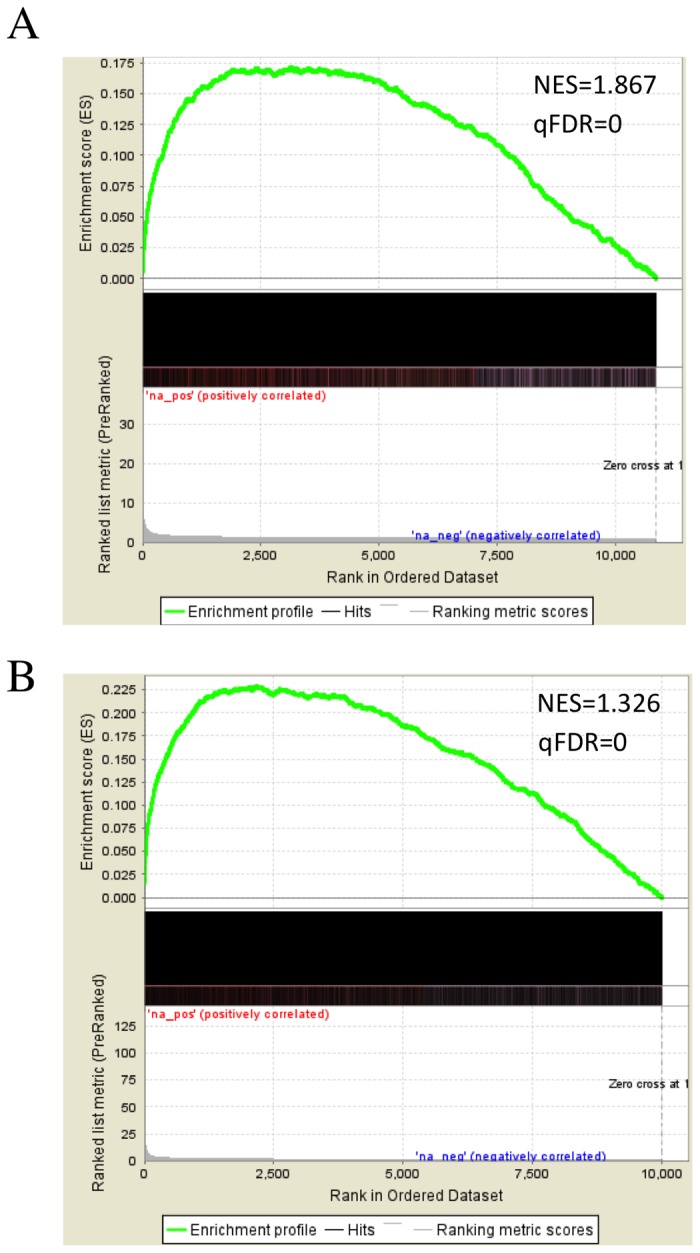
GSEA analyzed relationship of differential gene expression in WT/Runx3-/- cells and Runx3-bound genes in IL-2-activated CD8-TC and NKC.(A and B) All microarray genes were pre-ranked according to absolute linear fold changes of WT vs. Runx3-/- and statistical enrichment of Runx3-bound genes within the ranked list was evaluated in CD8-TC (upper panel) and NKC (lower panel). NES, normalized enrichment score.